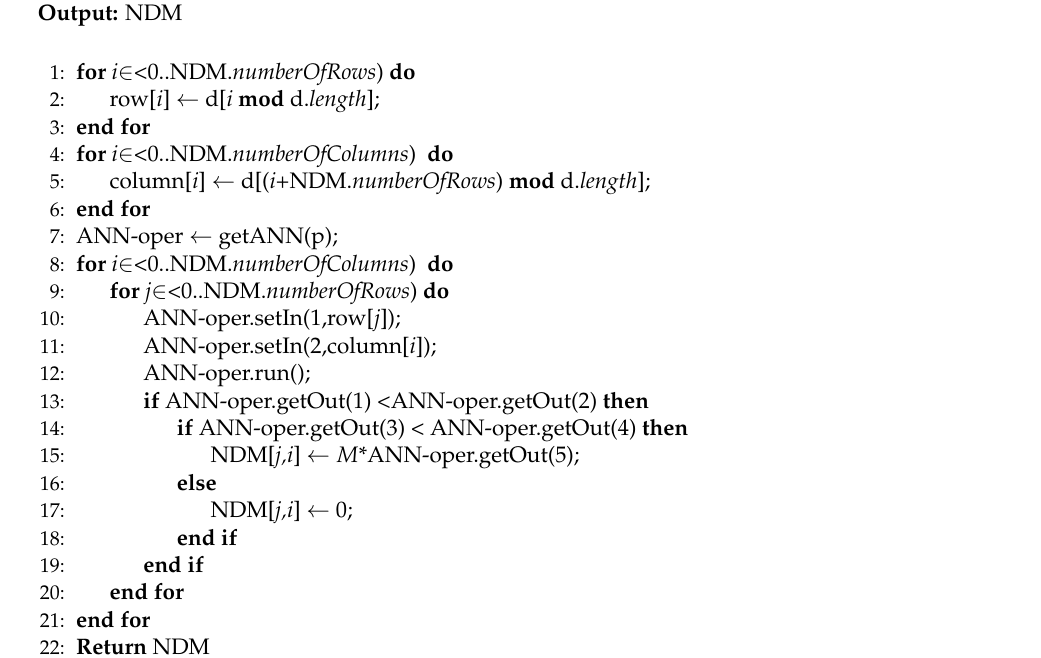
Algorithm 1 Pseudo-code of Oper1 .